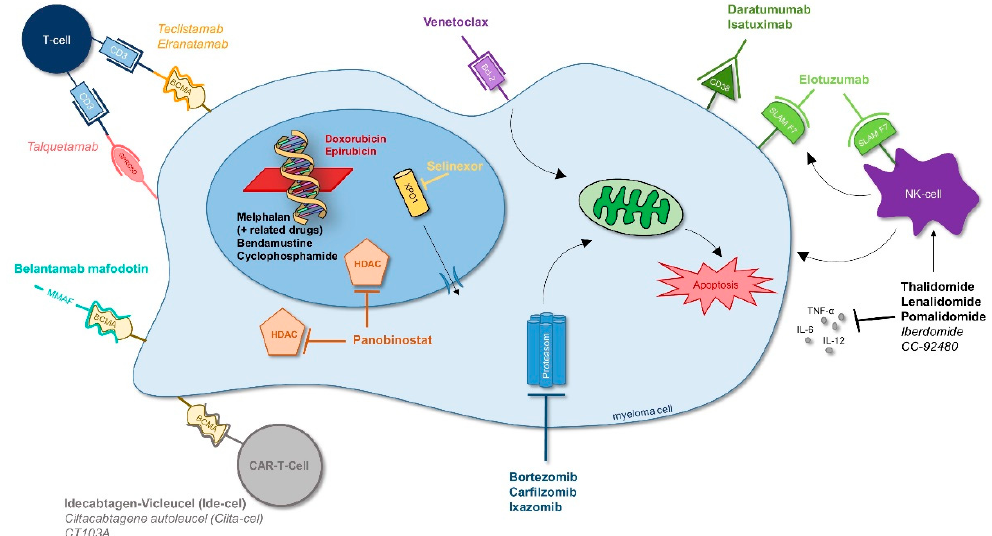
Figure 6. Scientific target sites for the treatment of MM. As modern research steadily unfolds new insights into the biology of MM and understanding mechanisms of resistance, scientific target sites for the treatment of MM diversify. Modern